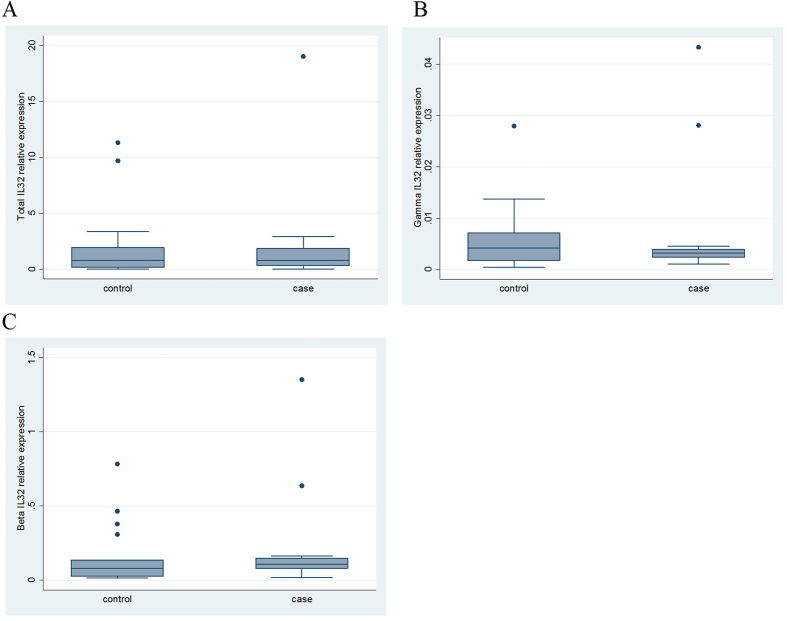
Distribution of relative expression of A.total IL32, B. IL32γ and C. IL32β in CD4+ T cells from cases and controls. IL32 expression relative to B2M housekeeper gene expression.